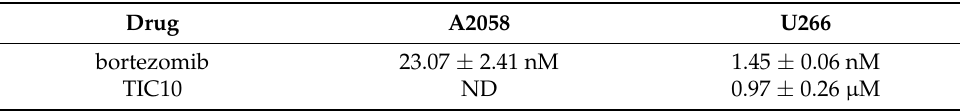
Table 1. IC 50 values were obtained after 72 h bortezomib (BOZ) or TIC10 treatment against A2058 and U266 cells.